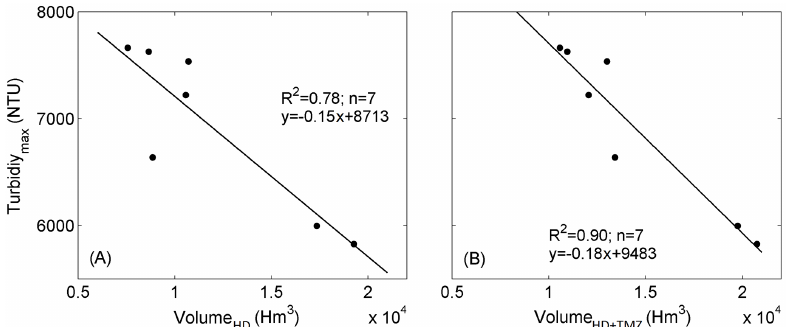
Figure 14. Turbidity maxima of the TMZ as a function of the water volume passed: (a) during the previous wet period and (b) during the previous wet period + the presence of the TMZ. Only Bordeaux is considered as it was not possible to estimate Turbidity max at Portets due to the number of missing data.